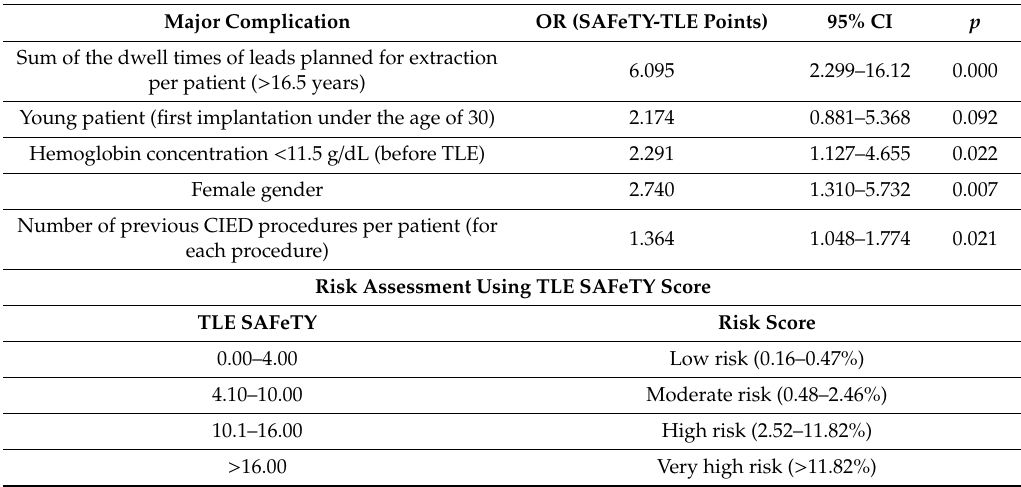
Table 3. Number of points predicting the risk associated with TLE as a result of the multivariate analysis of major